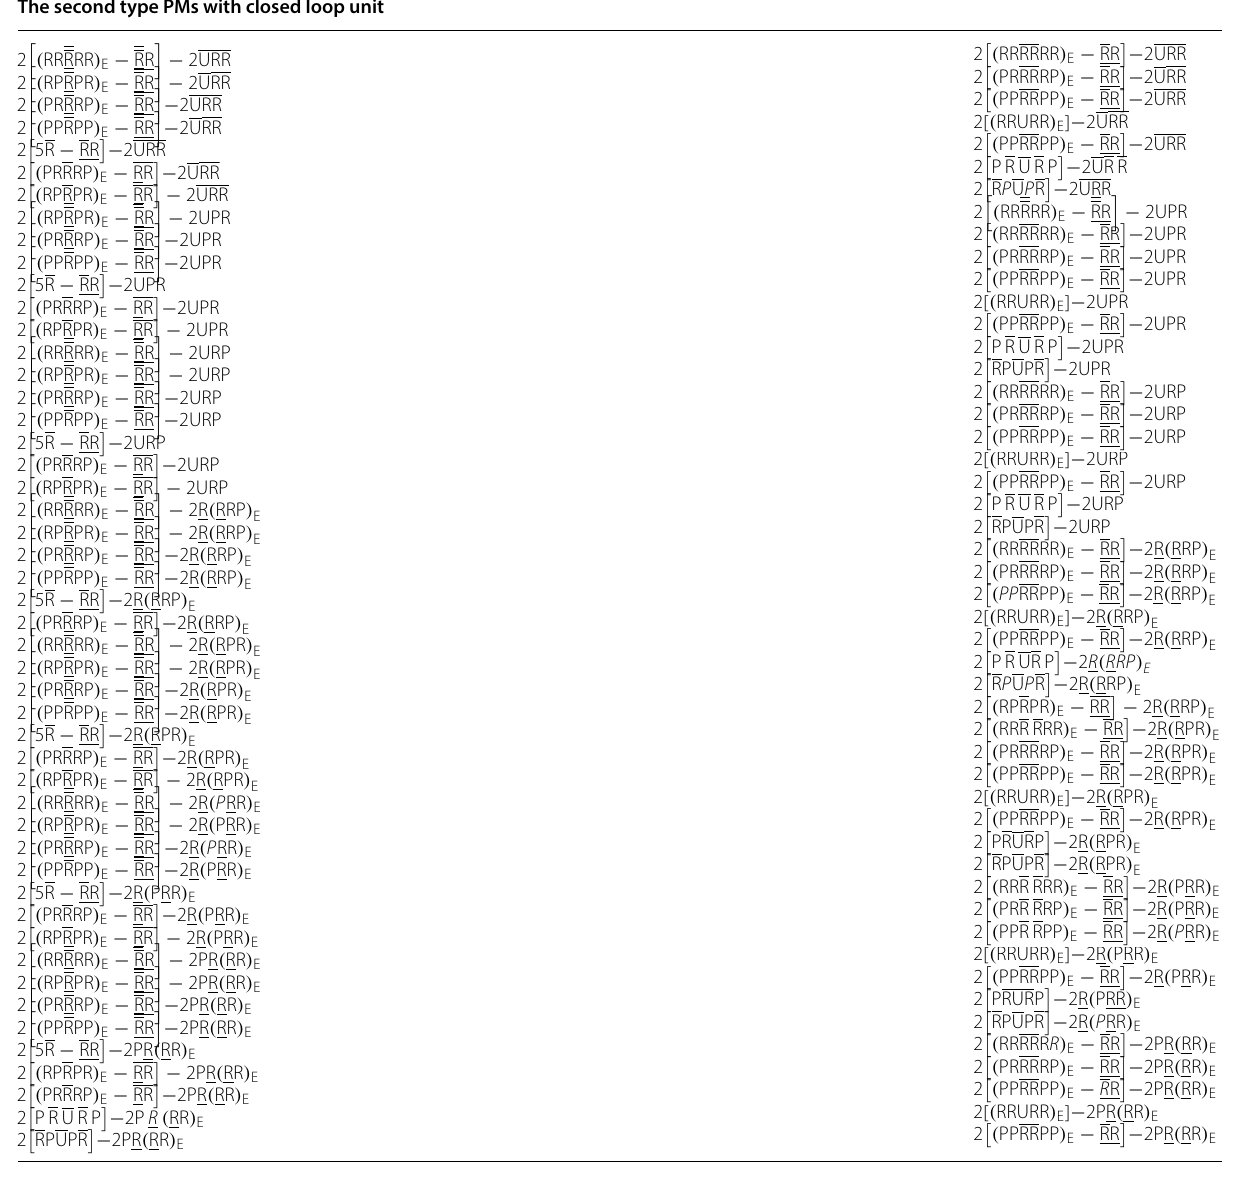
Table 6 The second type PMs with closed loop unit The second type PMs with closed loop